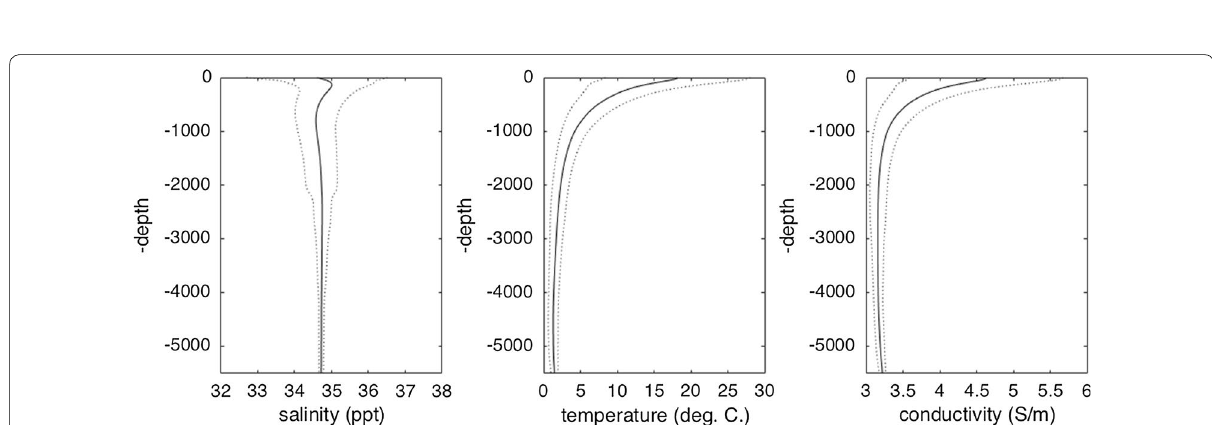
Fig. 3 Globally averaged conductivity profile with depth (profiles for temperature and salinity shown for comparison). Dash lines show the enve- lope of one standard